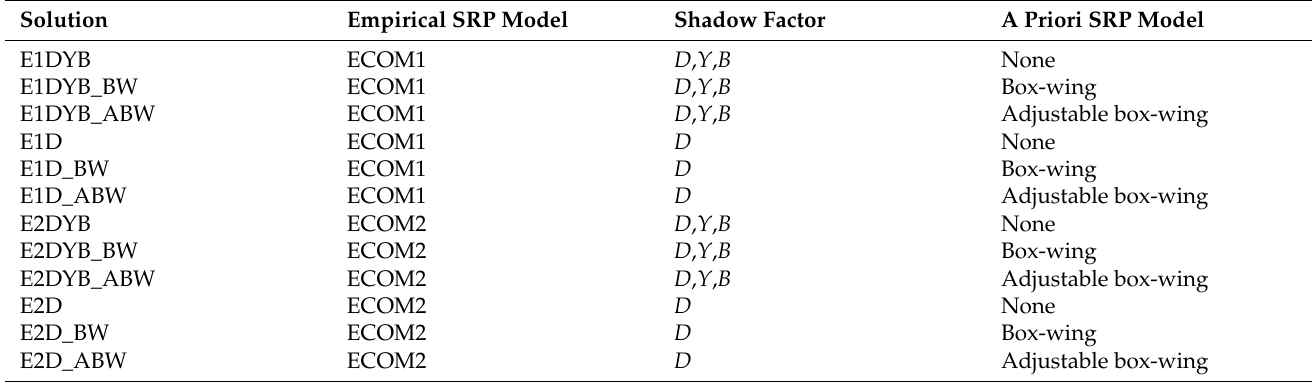
Table 1. Twelve cases of GPS daily precise orbit determination solutions using different methods in handling the a priori model, the parameterization model, and the shadow factor. Note that the directions in which shadow factor is applied refers to the parameterization model, and in the a priori model, the shadow factor is always applied. See Equations (8) and (9) for details.